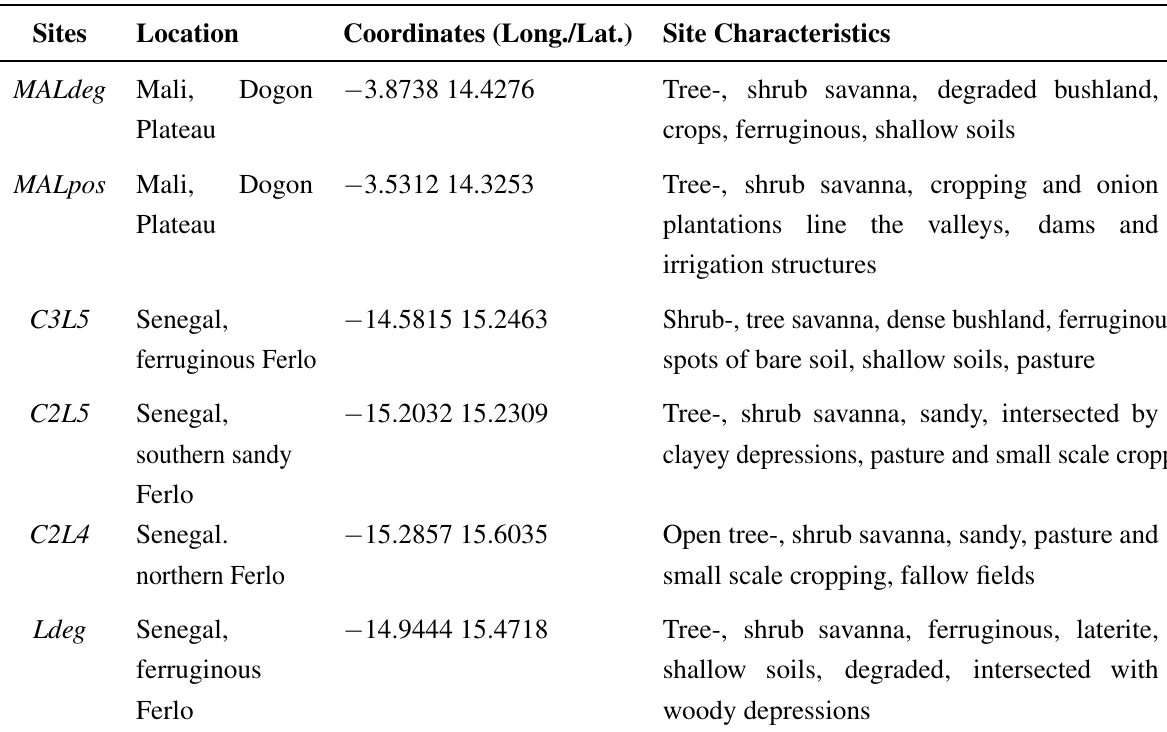
Table 1. Location and site characteristics for the Sahelian test sites presented in this study.